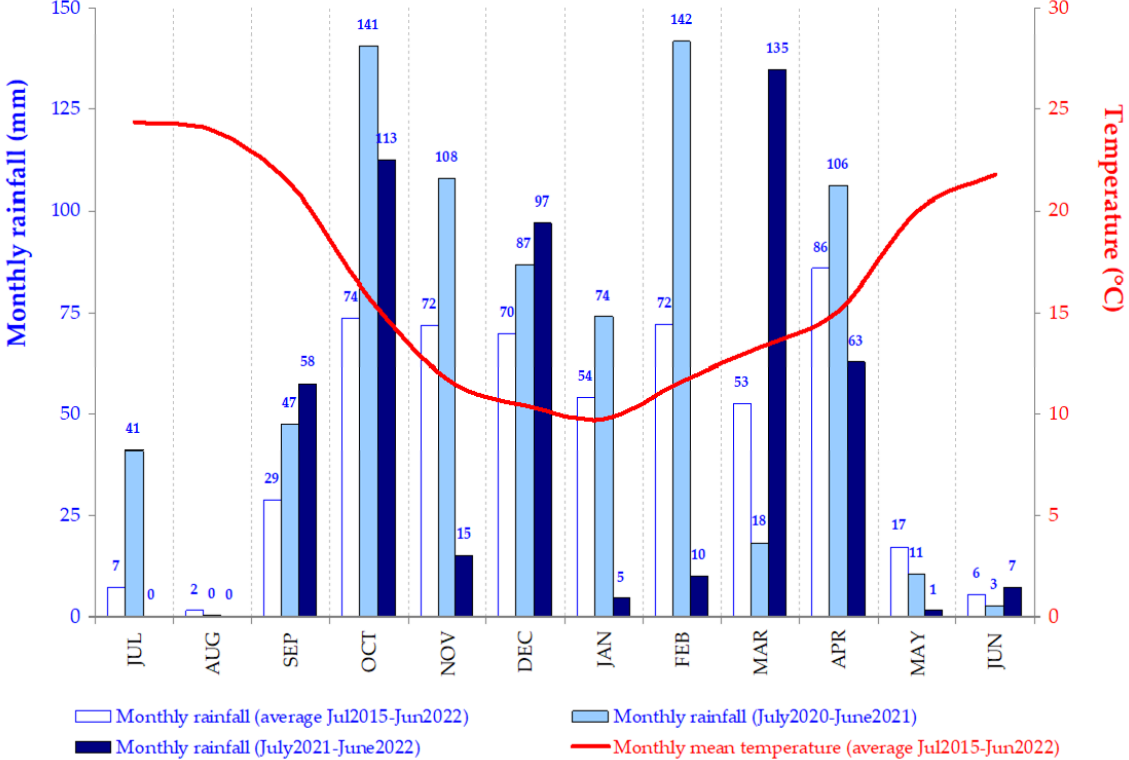
Figure 4. Thermo-pluviometric diagram of Mitra (Évora, Portugal) between July 2015 and June